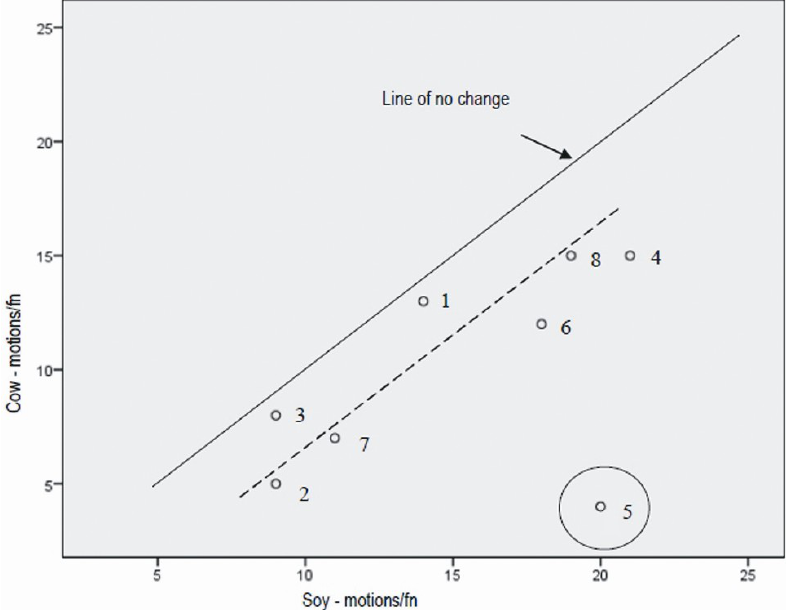
Figure 4. Total number of bowel motions per fortnight during the soy condition versus the cow’s milk